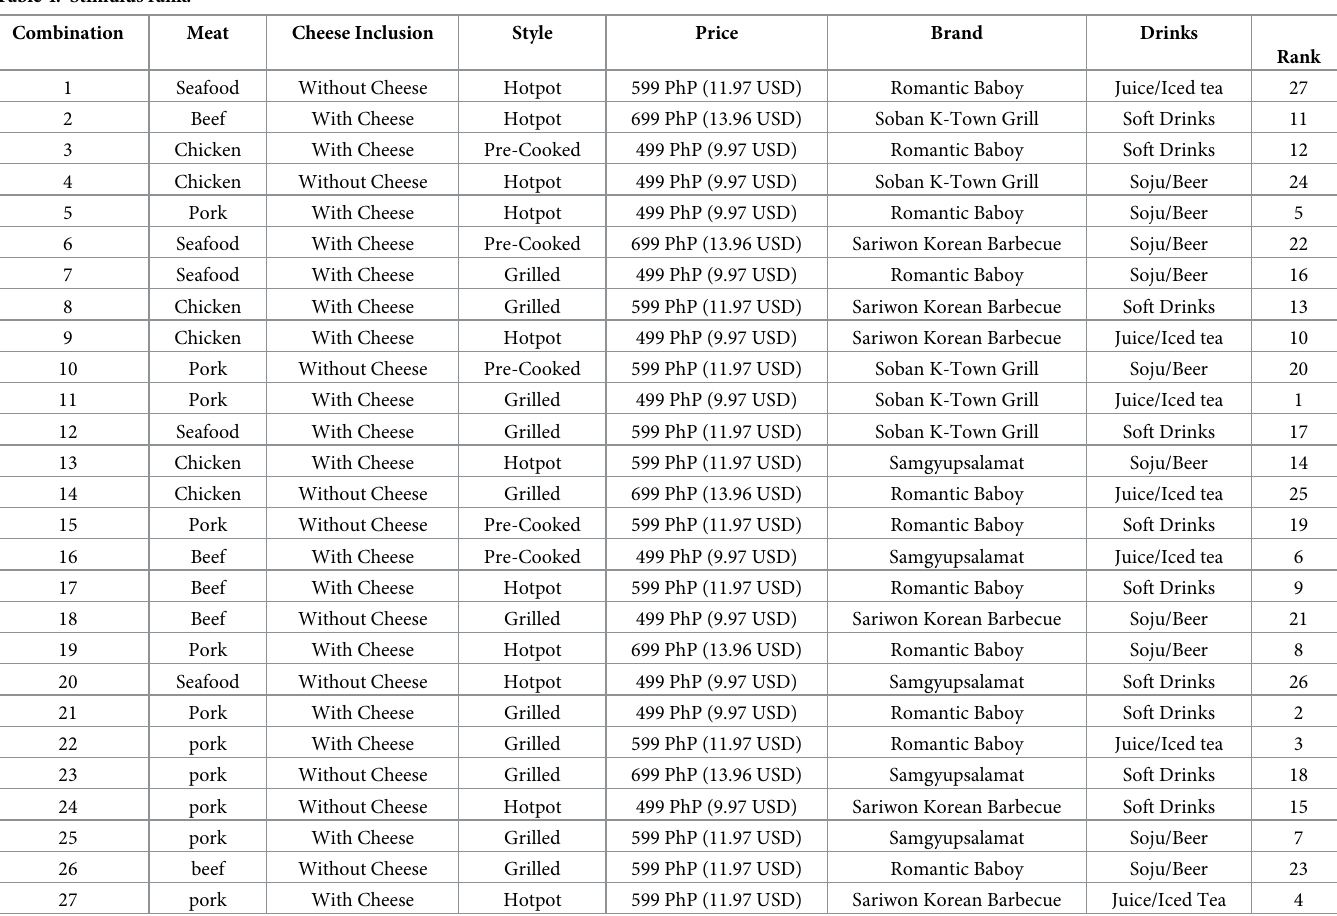
Table 4. Stimulus